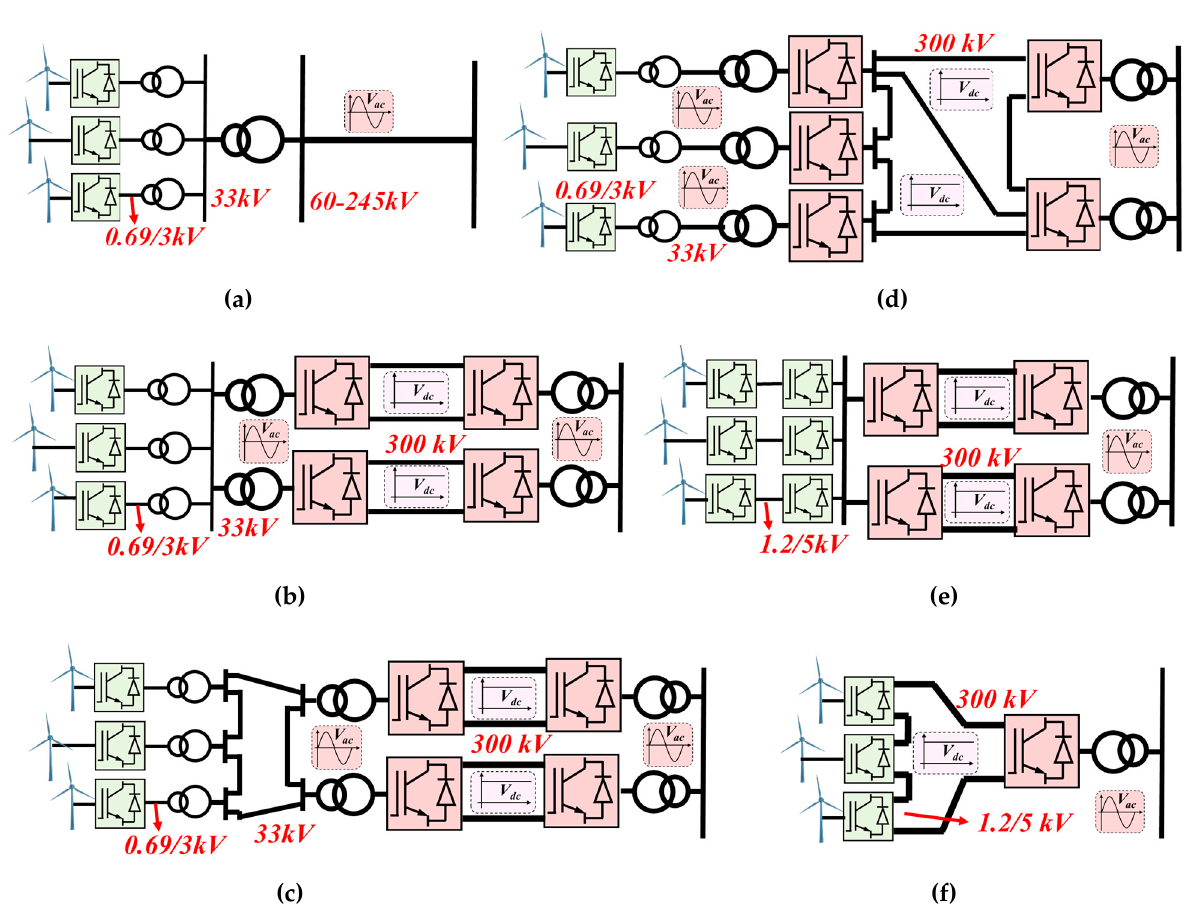
Figure 4. ( a ) Parallel AC connected system with HVAC based transmission system. ( b ) Parallel AC connected system with HVDC transmission. ( c ) Mesh connected AC system with mesh connected HVDC transmission. ( d ) Multi ‐ terminal DC grid ‐ based mesh structured HVDC transmission. ( e ) Parallel AC connected system with medium frequency transformer embedded HVDC based transmission system. ( f ) Series DC connected system with HVDC transmission system.